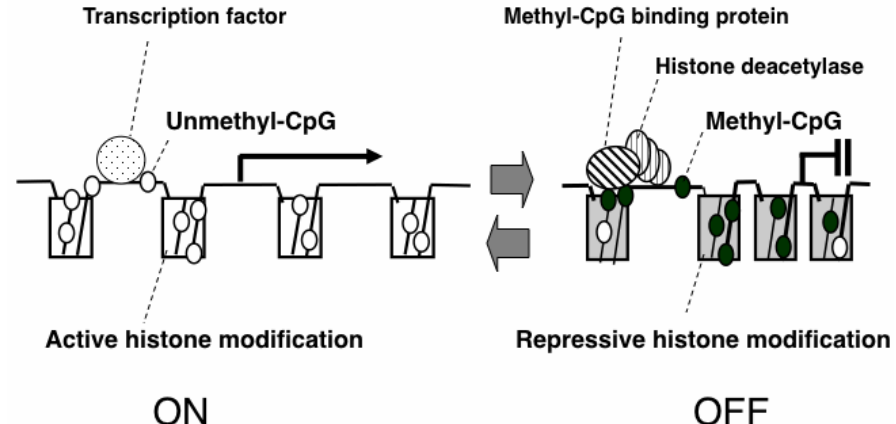
Figure 1. Epigenetic gene regulation via DNA methylation and histone modifications. A gene is usually activated by binding of a transcription factor to the promoter